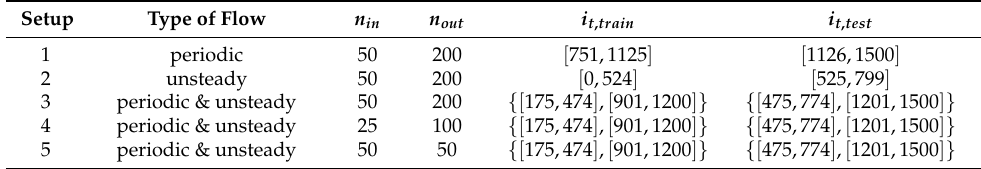
Table 4. Different setups for the performance of a grid